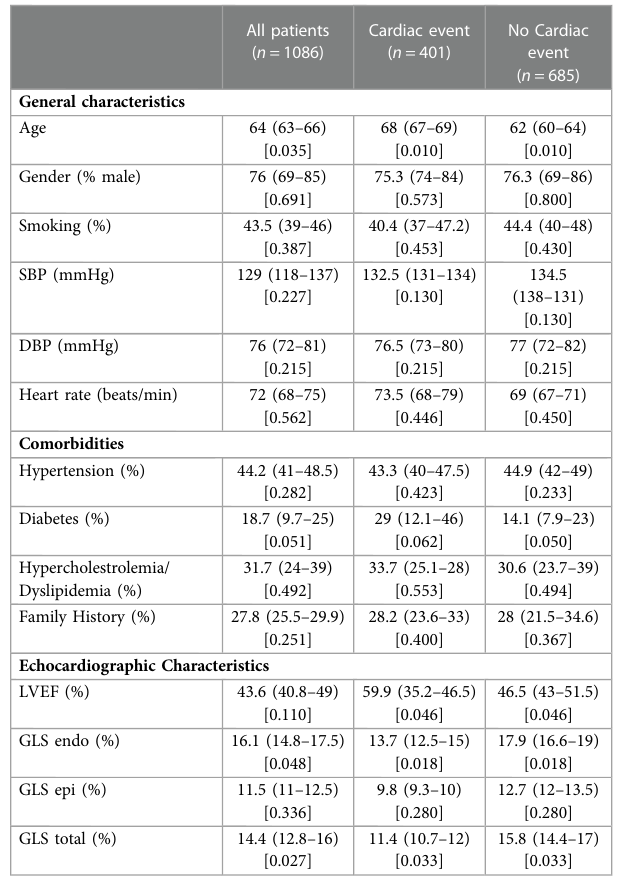
TABLE 4 Baseline characteristics of patients included in the prognostic studies (group 2).